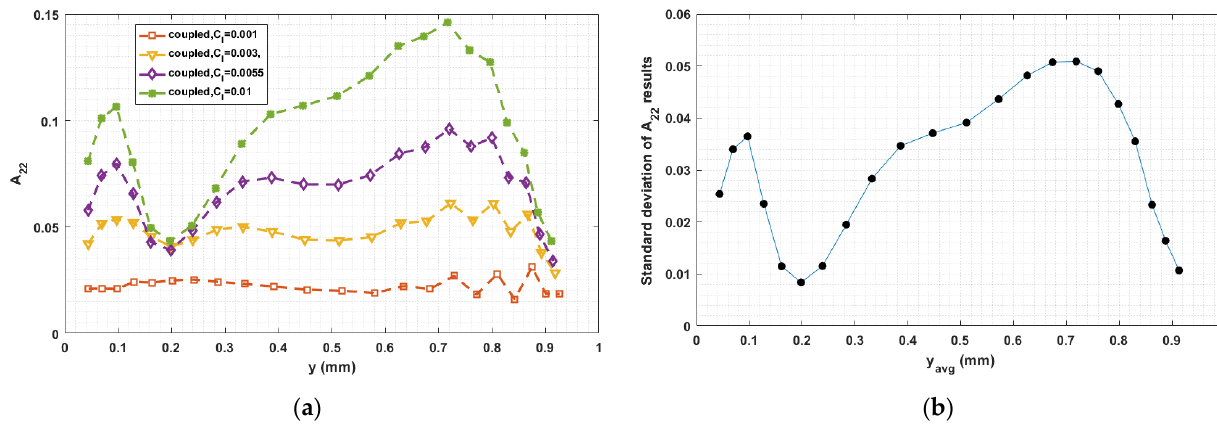
Figure 24. ( a ) Fiber orientation tensor component (cid:1827) (cid:2870)(cid:2870) at flow end; ( b ) standard deviation of the parametric study resulted (cid:1827) (cid:2870)(cid:2870) versus the averaged y locations.